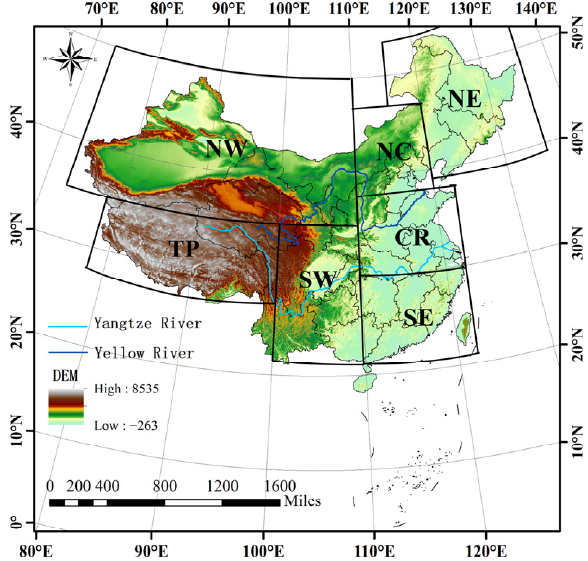
Figure 1. Topographic map of China. The polygons indicate the seven sub-regions defined as Northwest China (NW), North China (NC), Northeast China (NE), Tibetan Plateau (TP), Southwest China (SW), Central Region (CR), and Southeast China (SE). The inner filled colors are the Digital Elevation Model (DEM), the data of which are from Resource and Environment Science and Data Center, and the spatial resolution is 250 m.